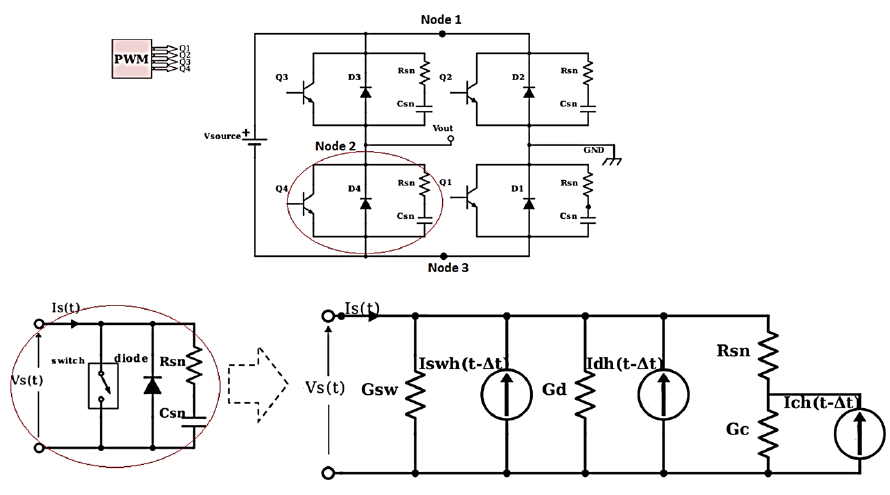
Figure 9. Full bridge power inverter model and NIS analysis of power electronics using Associated Discrete Circuit (ADC)